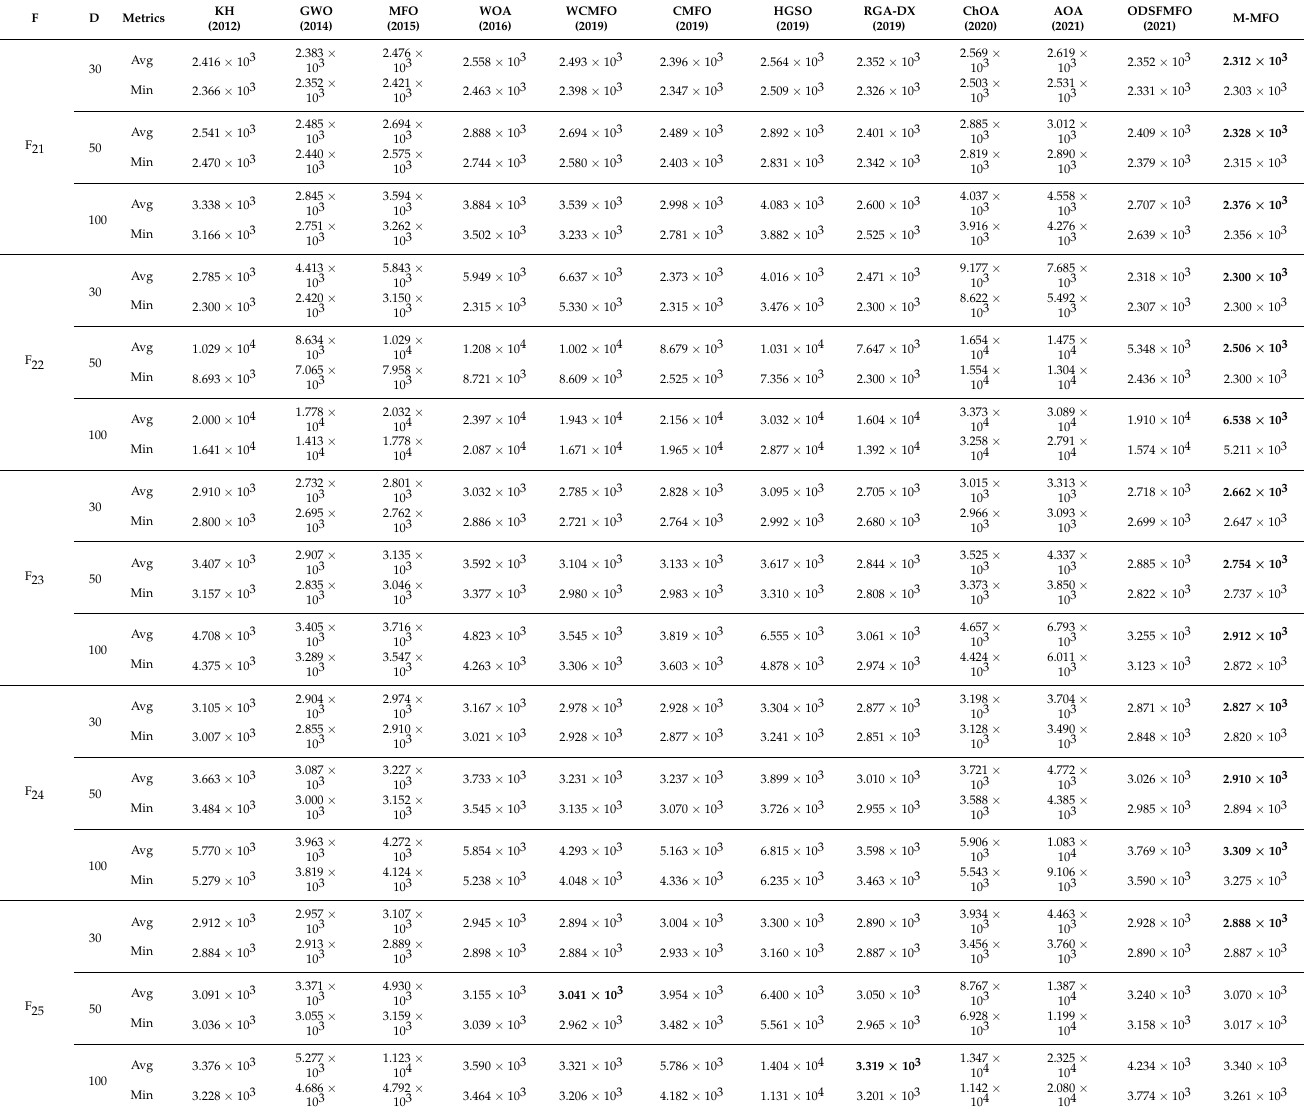
Table A4. Results of the comparative algorithms on composition test